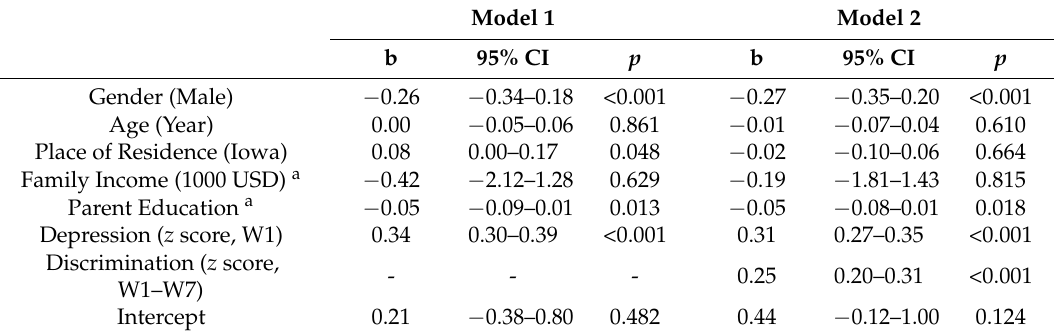
Table 3. Summary of linear regressions to test the main effects of place, socioeconomic status (SES), gender, and discrimination on average depressive symptoms over 18 years ( n = 889).